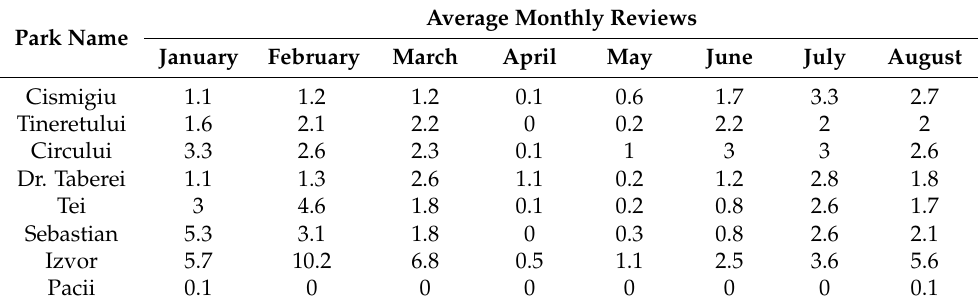
Table 3. The number of average monthly reviews on